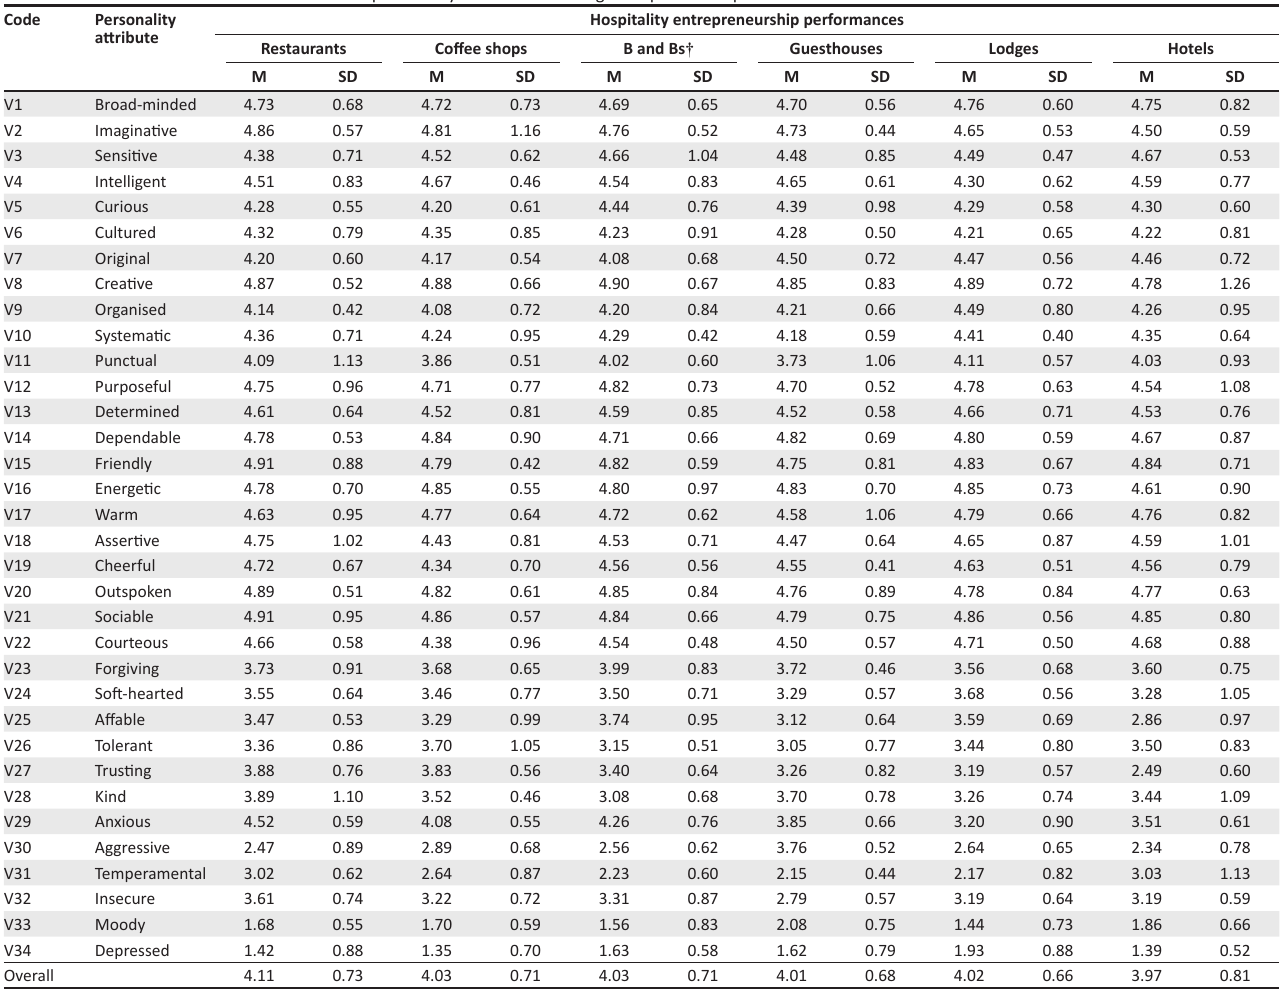
TABLE 2: Means and standard deviations for the personality attributes affecting entrepreneurial performance.